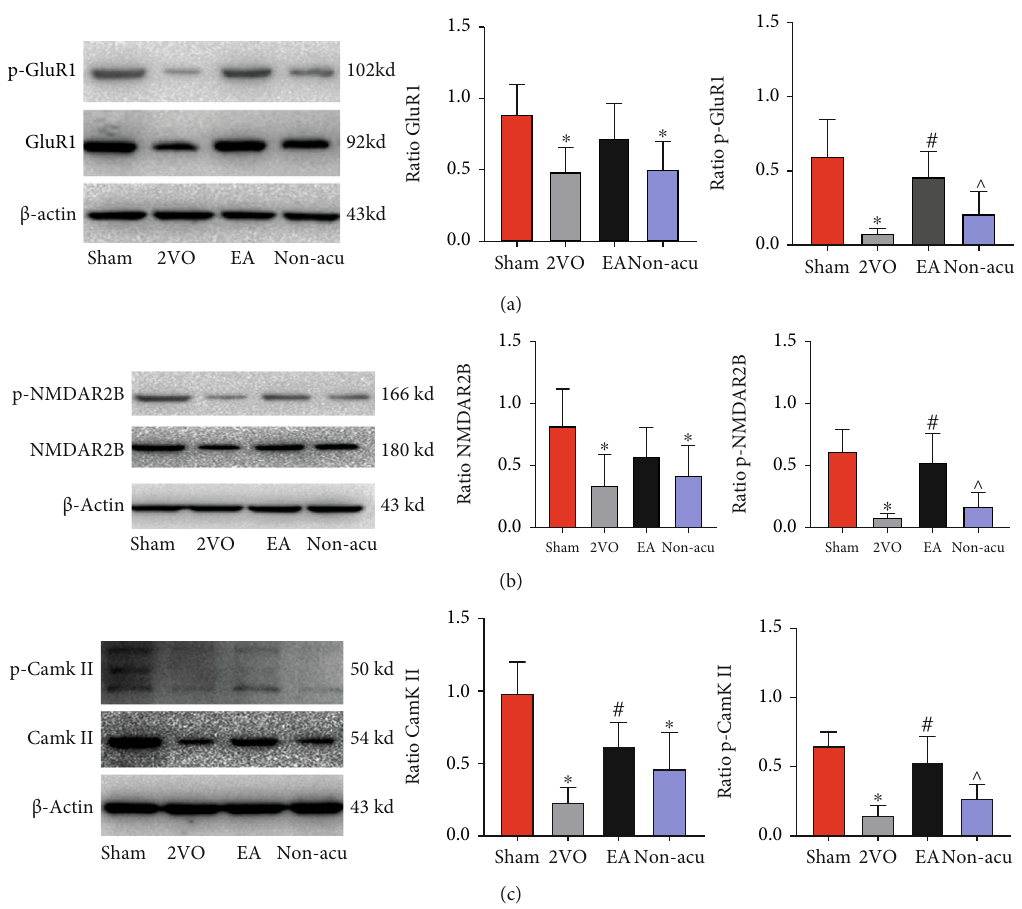
Figure 4: Electroacupuncture improves the expression and phosphorylation level of synapse-related protein in the hippocampus of VCI model rats. (a) Expression levels of GluR1 protein and its phosphorylation levels in the hippocampal region of rats in all groups. (b) Expression levels of NMDAR2B protein and its phosphorylation levels in the hippocampal region of rats in all groups. (c) Expression levels of CaMKII protein and its phosphorylation levels in hippocampal region of rats in all groups. ∗ P < 0 : 05 and ∗∗ P < 0 : 01 , Sham vs. 2VO and Sham vs NA; # P < 0 : 05 , 2VO vs EA; ^ P < 0 : 05 , EA vs.